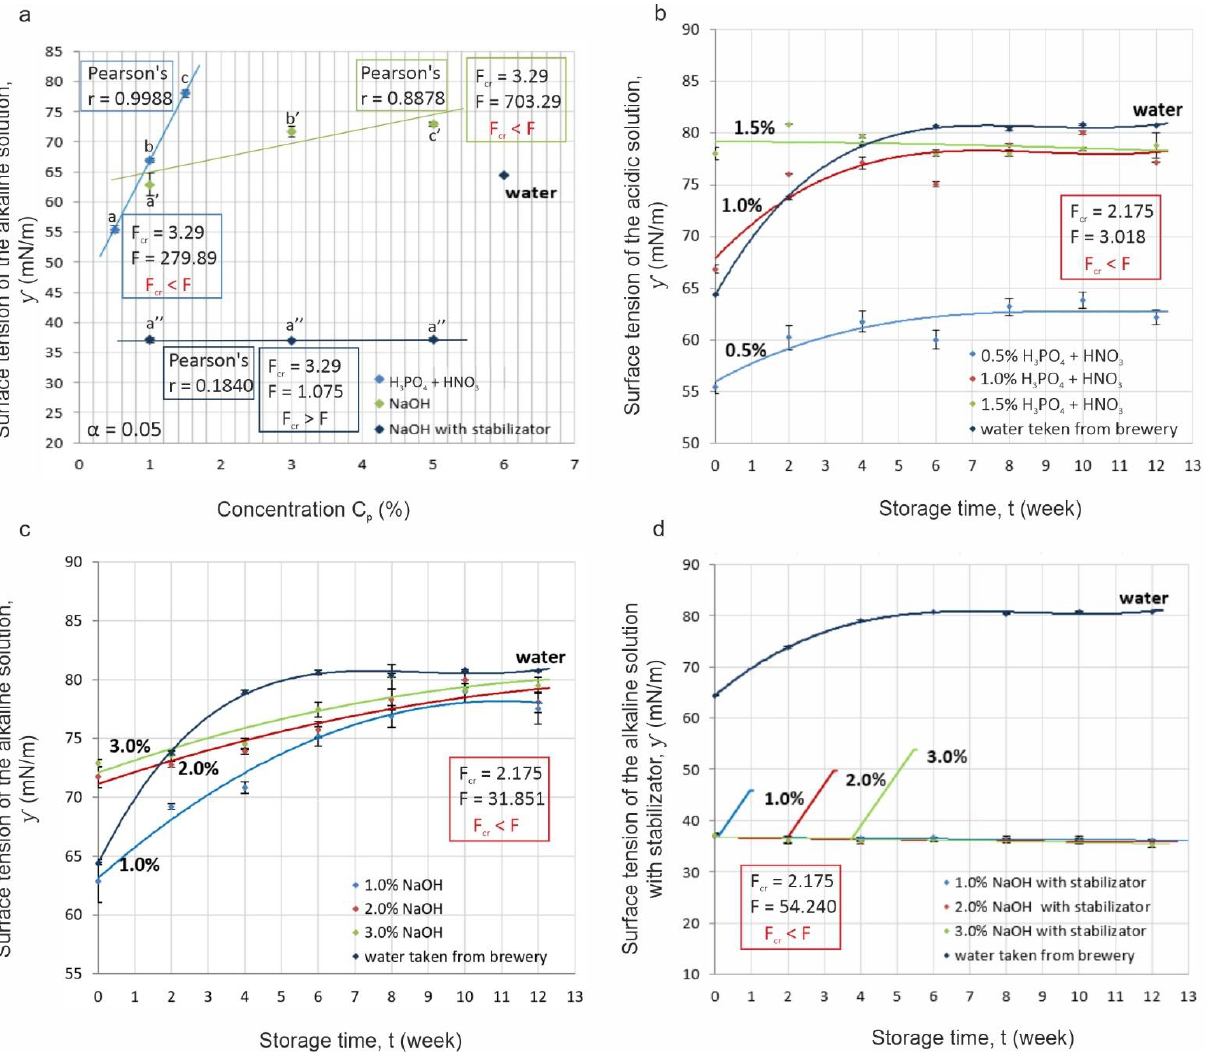
Figure 3. Relationships of equilibrium surface tension values with: ( a ) concentration of solutions (C p ); ( b ) storage time (t) of acidic solution H 3 PO 4 + HNO 3 ; ( c ) storage time (t) of alkaline solution NaOH; ( d ) storage time (t) of alkaline solution with stabilizer NaOH + S ( a – c ; a’–c’; a”–c” different letters in the same column indicate significant statistical difference Tukey’s HSD test, α = 0.05).